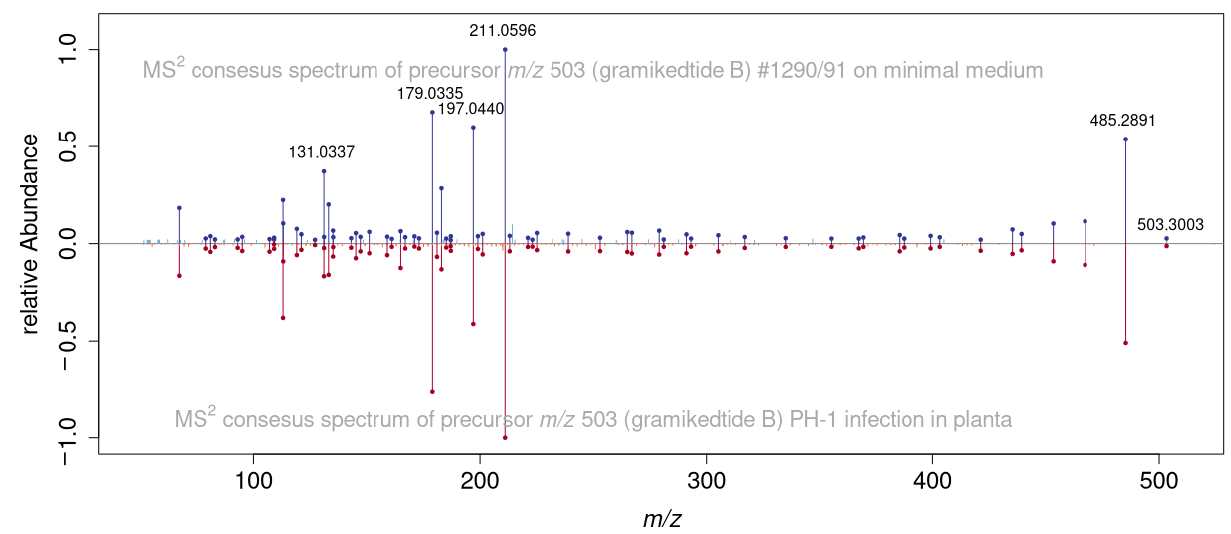
Figure 8. Comparison of LC-HRMS/MS spectra of gramiketide B m/z 503.3003 produced by the kmt6 ∆ strain in liquid minimal medium (blue) and the metabolite produced by PH-1 in planta (red) showing a high similarity (dot product similarity score of 0.984) of the spectra.